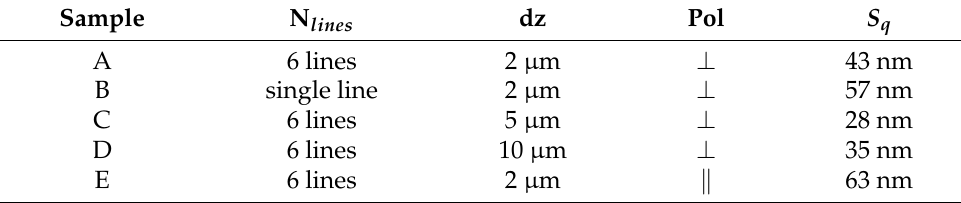
Table 1. Sample fabrication parameters and measured root mean squared (RMS) roughness before thermal annealing ( S q ). Pol indicates the polarization orientation with respect to the line writing direction, and dz is the spacing between horizontal planes.